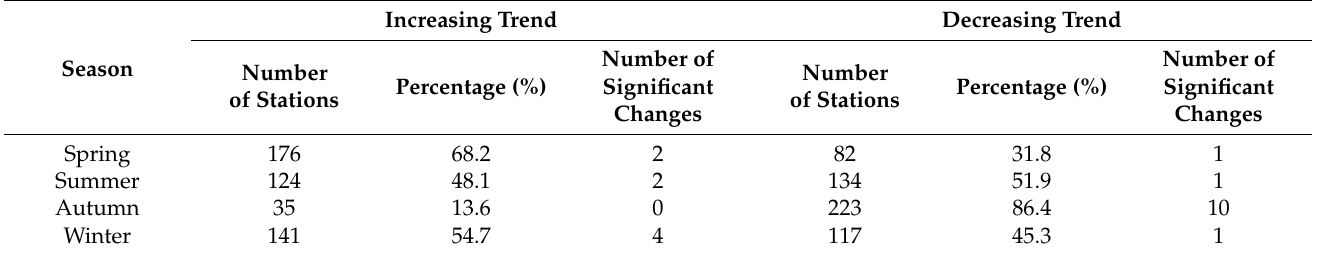
Table 2. Precipitation trends for different seasons in the Haihe River